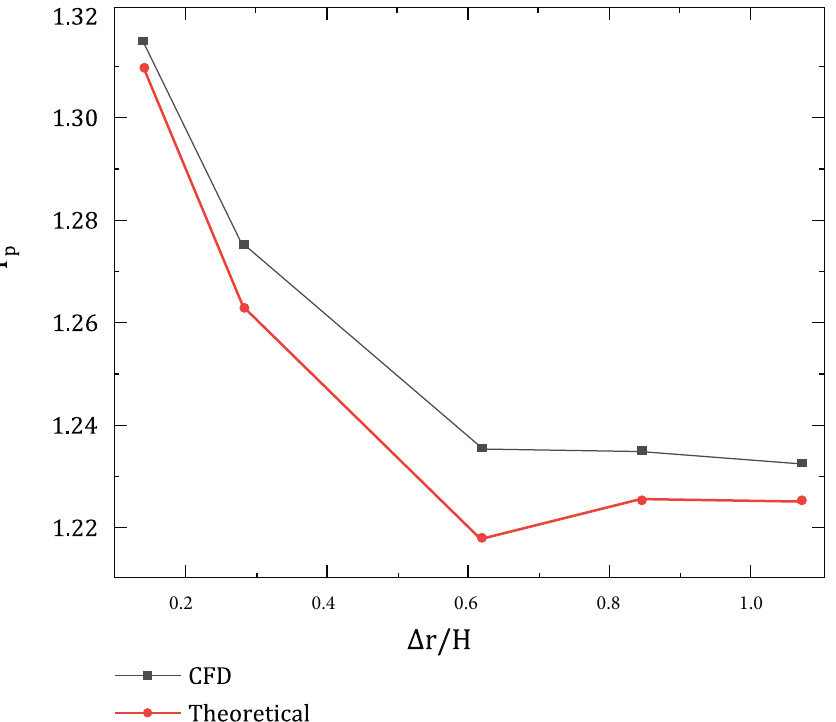
Figure 20: Comparison of results of theoretical model and CFD for SPL coe ffi cient in bleed system with di ff ering radial height of plenum